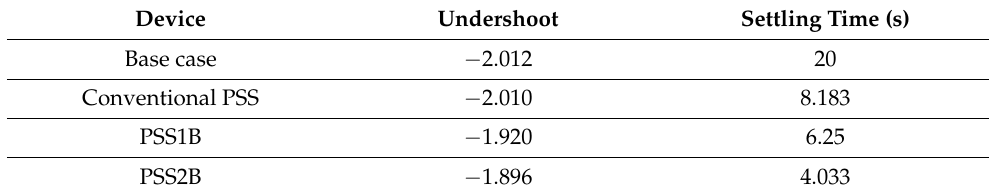
Table 19. Maximum overshoot and settling time of rotor angle deviation at light